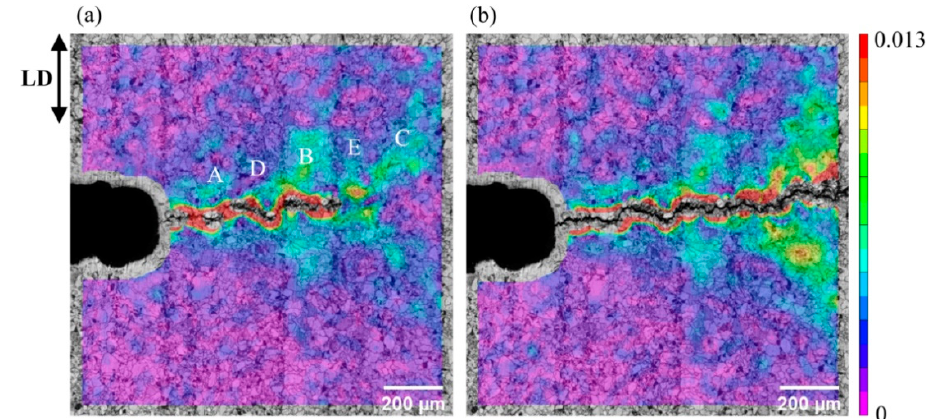
Figure 8. Von Mises strain fields of the LD1 specimen under 10 × objective lens: ( a ) a = 1.2 mm, Figure 8. von Mises strain fields of the LD1 specimen under 10× objective lens: ( a ) a = 1.2 mm, N = N = 80,000 cycles; ( b ) a = 1.75 mm, N = 95,000 cycles. 80,000 cycles; ( b ) a = 1.75 mm, N = 95,000 cycles.